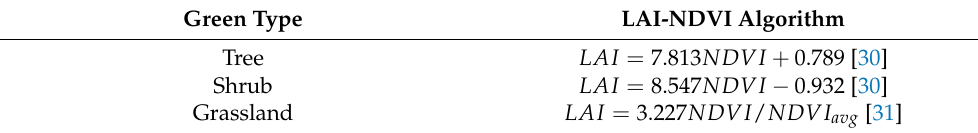
Table 1. Leaf area index (LAI)-normalized difference vegetation index (NDVI) algorithm of different green types.